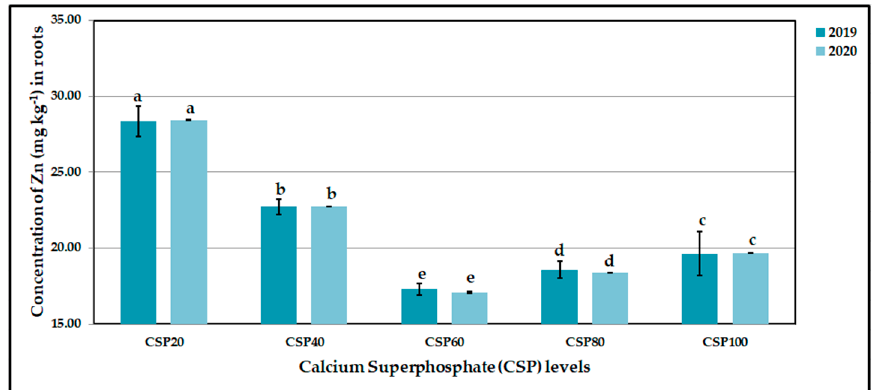
Figure 11. Influence of calcium superphosphate (CSP) levels on root zinc (Zn, mg kg − 1 ) contents of CaCO 3 ‐ stressed sweet potato plants in 2019 and 2020 seasons. Bars with a different letter indicate significant difference between treatments at p ≤ 0.05. CSP 20 , CSP 40 , CSP 60 , CSP 80 , and CSP 100 represent CSP added as a soil application at 69, 138, 207, 276, and 345 kg ha − 1 , respectively.